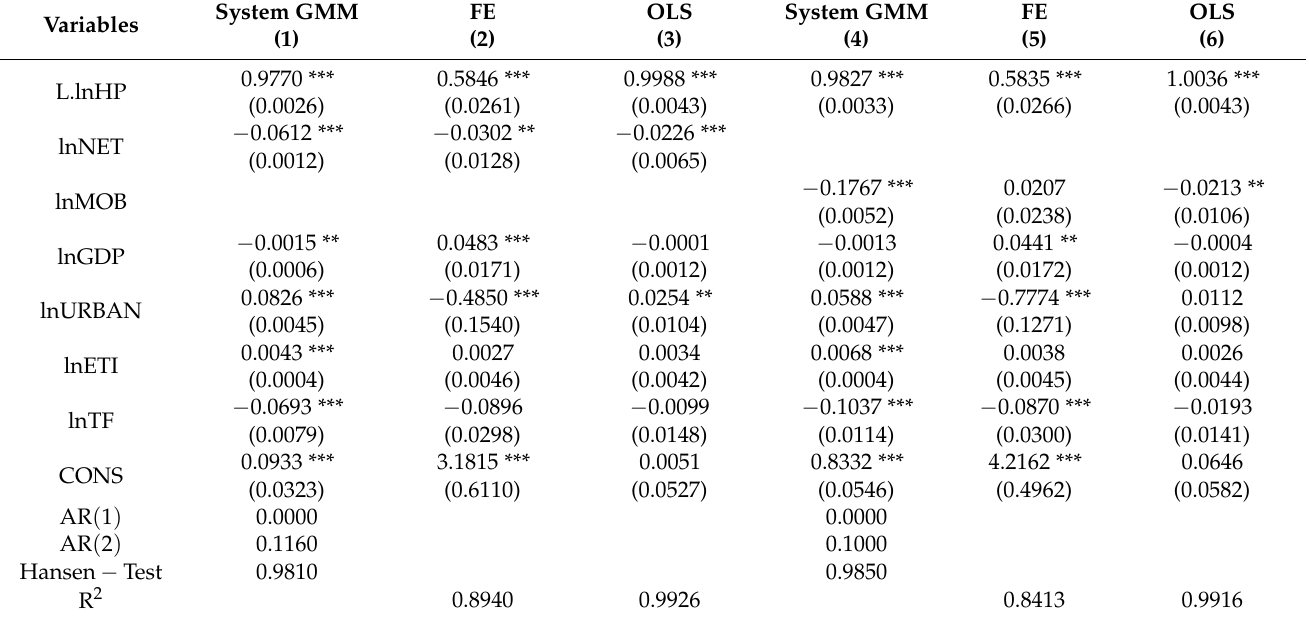
Table 3. The result of benchmark